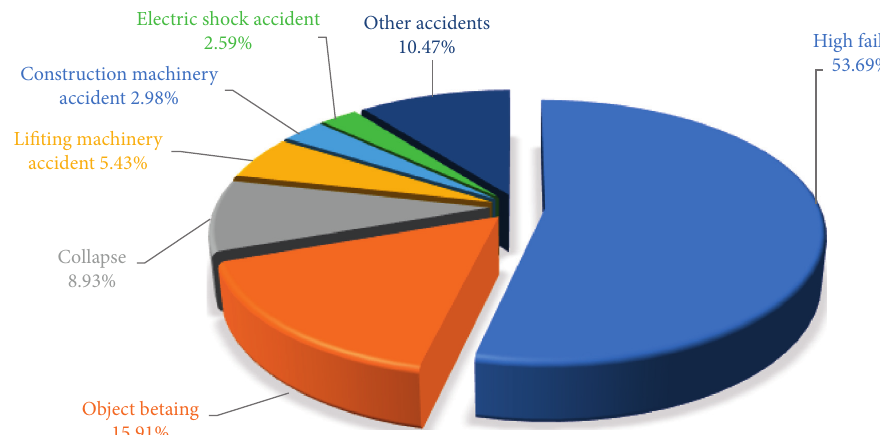
Figure 3: Types of production safety accidents of housing and municipal projects in China in 2019.